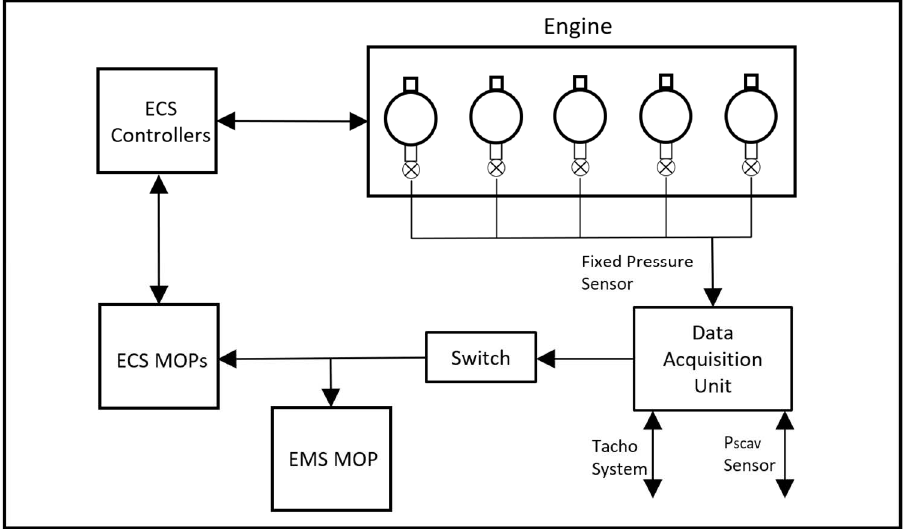
Figure 1. Engine control system schematic, simpli fi ed.